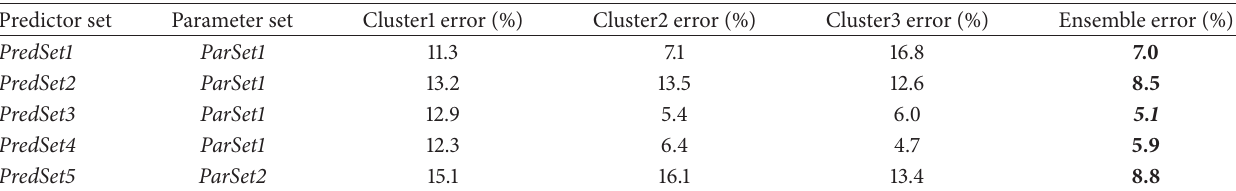
Table 7: Mean absolute errors (%) for annual Indian summer monsoon rainfall prediction by individual RNN cluster models and ensemble model for test period 2001–2013. Reports minimum error of 5.1 %.